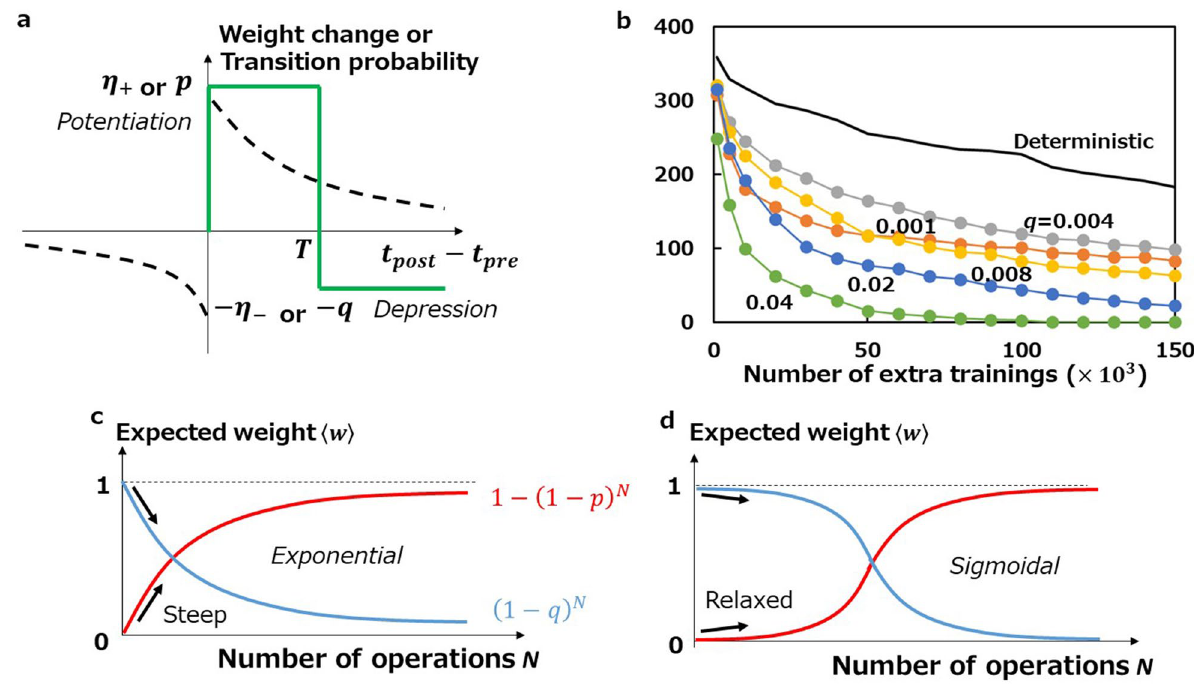
Figure 1. Introduction of stochastic S-STDP. ( a) Schematics of S-STDP. While the synaptic weight update has exponential-like dependence on t post − t pre in standard STDP (broken curves), S-STDP is characterised by a rectangular dependence (green line). Since an update takes place at the occurrence of a post-neuron’s fire, we only consider the case of t post − t pre > 0 for S-STDP. In the scheme of stochastic S-STDP with binary weights, the weight change η + and η − are read as the transition probabilities p from w = 0 to 1 for potentiation and q from 1 to 0 for depression, respectively. ( b) Memory maintenance characteristics of learning with conventional stochastic S-STDP. The number of neurons that retain the digit memorised during the initial learning is plotted against the number of extra trainings (number of training samples presented for additional learning). Depression probability q is varied while potentiation p is fixed at 0.04. For comparison the characteristic of learning with deterministic S-STDP using continuous weights is shown as a thick line, for which we employ a linear weight-dependent update model 33,37 , where � w = η + ( w max − w ) for potentiation and � w = η − ( w − w min ) for depression with η + = 0.04 and η − = 0.008 , respectively. ( c,d) Evolutions of expected weights for conventional stochastic S-STDP (c) and proposed "sigmoidal stochastic" S-STDP (d)